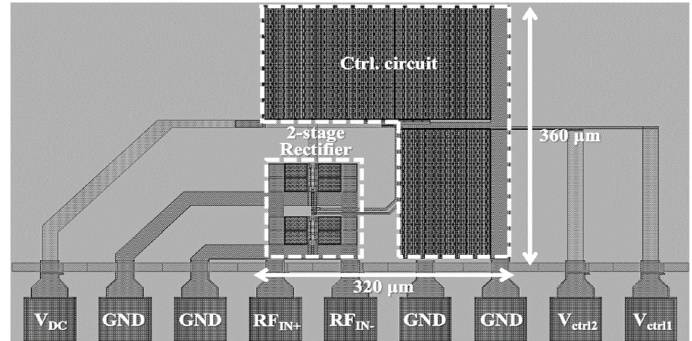
Figure 12. Chip layout of the proposed CMOS RF–DC converter.